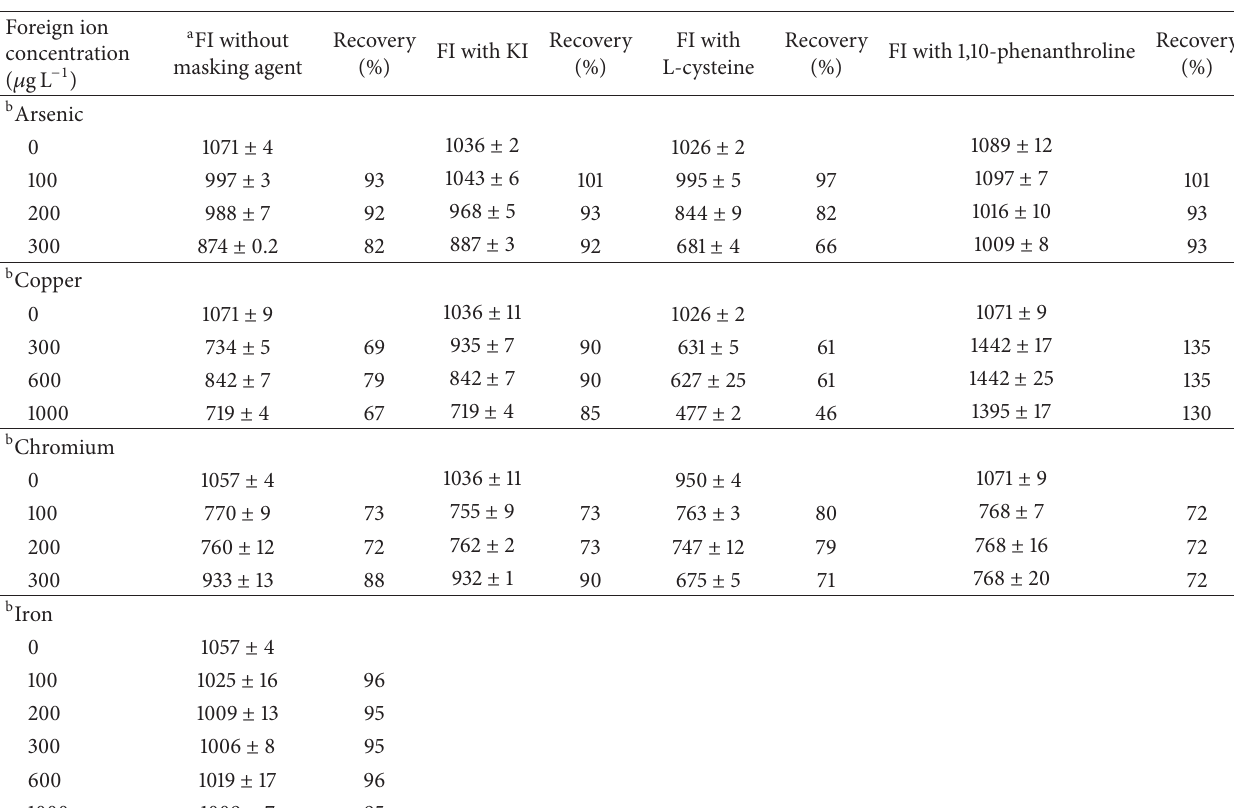
Table 3: Results of the effect of foreign ions and masking agents on the analytical signal of 10 𝜇 gPbL −1 . Foreign